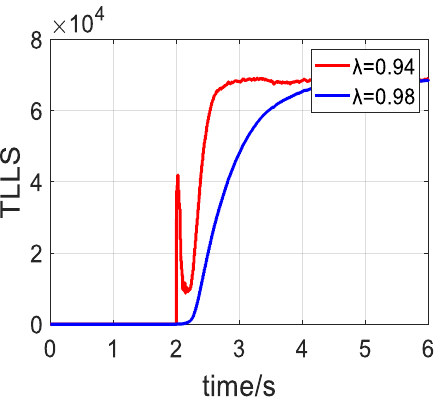
Figure 7. Tire linear longitudinal stiffness (TLLS) with different λ .